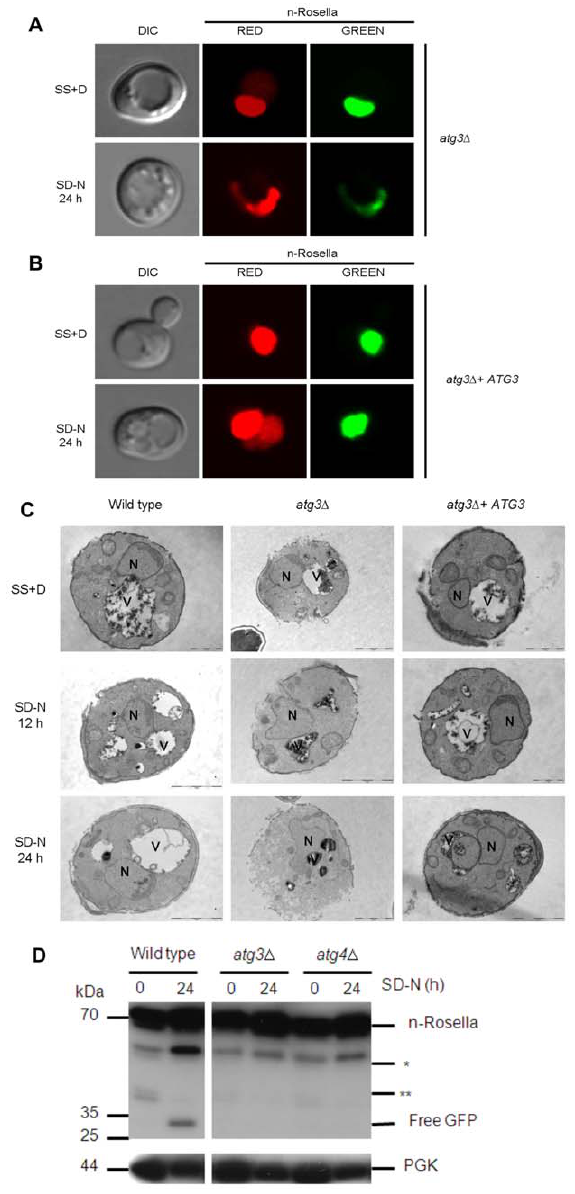
Figure 7. Deletion of the ATG3 gene abrogates the delivery of n-Rosella to the vacuole and influences nuclear morphology. ( A ) atg3 D and ( B ) atg3 D + ATG3 cells expressing n-Rosella were imaged Figure 6. The deletion of the ATG6 or ATG11 genes does not under growing (SS + D) and nitrogen starvation (SD 2 N) conditions (24 abrogate the delivery of n-Rosella to the vacuole. ( A ) atg11 D hours after commencement of nitrogen starvation). ( C ) Electron cells expressing n-Rosella were imaged under growing (SS + D) and microscopy images of wild type (BY4741), atg3 D and atg3 D + ATG3 nitrogen starvation (SD-N) conditions (0, 24, 48 and 72 hours after cells expressing n-Rosella were imaged under growing (SS + D) and commencement of nitrogen starvation). ( B ) atg11 D cells co-expressing nitrogen starvation (SD-N) conditions. Nitrogen-starved cells were both nuclear reporters were imaged under growing (SS + D) and sampled for imaging after 12 and 24 hours. Examples of contacts nitrogen starvation (SD-N) conditions and the percentage of cells between the nucleus and vacuoles as well as alterations in nuclear N showing accumulation of fluorescence over time determined: ¤ green morphology are presented. N, nucleus; V, vacuole. Bar, 2 m m. ( D ) Wild red (NAB35-DsRed.T3) only; . green and red. ( C ) (Nvj1p-EYFP) only; type, atg3 D and atg4 D cells expressing n-Rosella were starved in Wild type, atg6 D , atg11 D , atg8 D and atg10 D cells expressing n-Rosella SD( 2 N) medium for 0 and 24 hours, and the levels of free GFP were starved in SD(-N) medium for 0 and 24 hours, and degradation degradation product monitored by immunoblotting as described in product (free GFP) levels were monitored by immunoblotting as Materials and Methods. Cytosolic PGK was detected as a loading described in Materials and Methods. Cytosolic PGK was detected as a control. *indicates the presumptive degradation product of n-Rosella loading control. *indicates the presumptive degradation product of n- lacking the NAB35 nuclear targeting signal. **indicates non-specific Rosella lacking the NAB35 nuclear targeting signal. degradation product observed only in growing cells (0 hours). doi:10.1371/journal.pone.0040013.g006